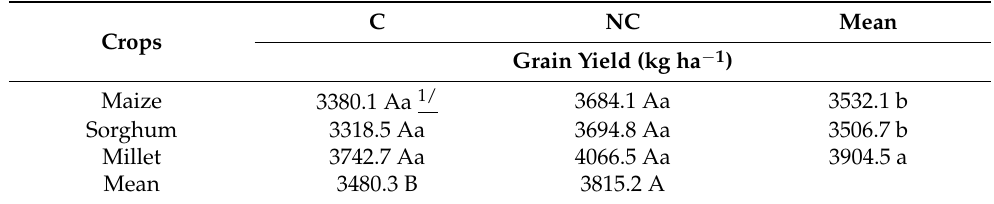
Table 4. Soybean grain yield after second-season crops of maize, sorghum, and millet in compacted (C) and uncompacted (NC) soils. C NC Mean Crops Grain Yield (kg ha − 1 ) Maize 3380.1 Aa 1/ 3684.1 Aa 3532.1 b Sorghum 3318.5 Aa Millet 3815.2